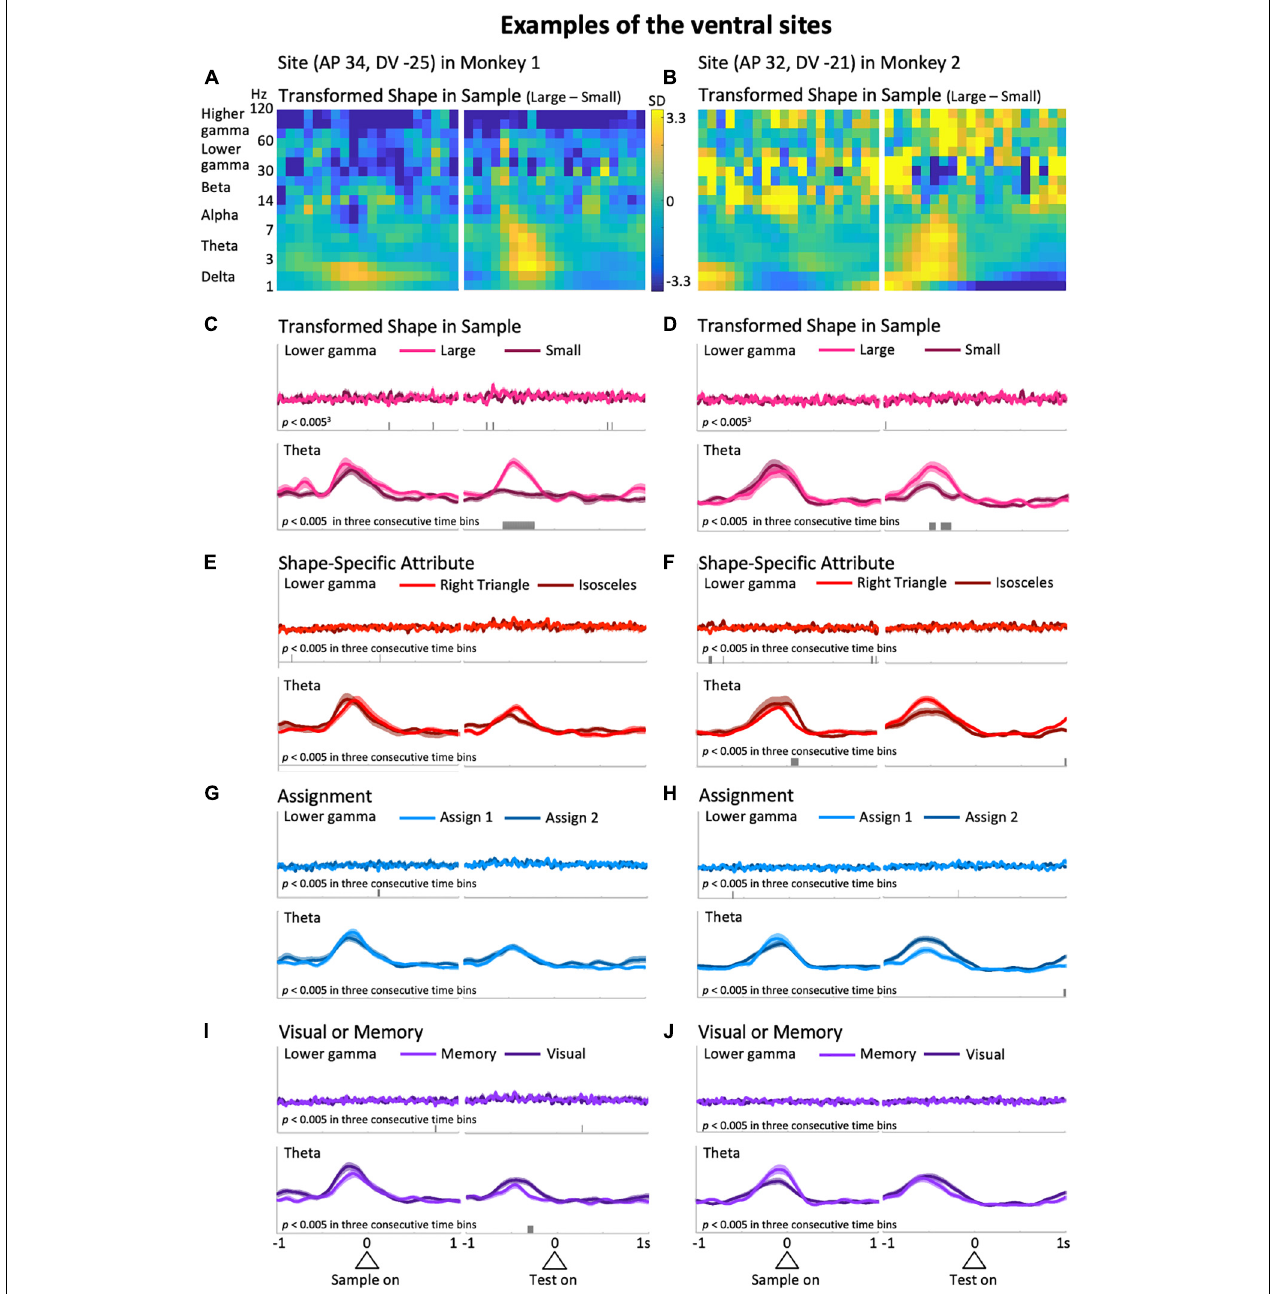
FIGURE 3 | Typical examples from the ventral side of the LFPC in the two monkeys. The left column was obtained from the site with coordinates (AP 34, DV –25); i.e., 34 and –25 mm in the anterior-posterior and dorsal-ventral axes, respectively, while the right column is from (AP 32, DV –21). (A,B) The difference in the time-frequency spectra between large and small sizes of the shape presented in the sample period. (C,D) The mean upper envelopes of lower-gamma (top) and theta (bottom) waves sorted based on the sample-shape scale factor. (E–J) The mean upper envelopes sorted based on variables of shape-specific attributes (E,F) , assignment (G,H) , and visual or memory (I,J) . The scales for the mean upper envelopes were identical in each column. Small bars in each mean upper envelope plot indicate the time regions showing significant differences ( p < 0.005) in three consecutive time bins.